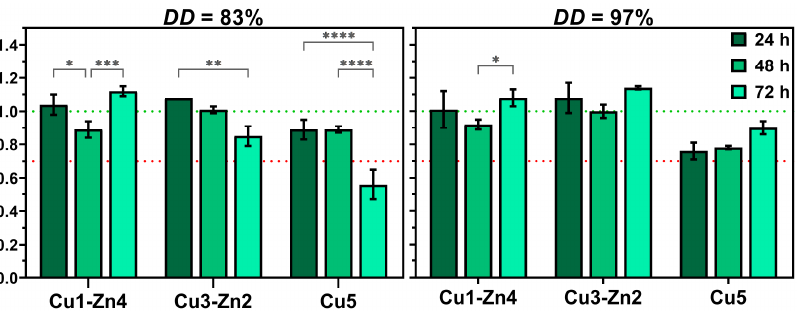
Figure 8. Cell viability of HEK293 cells cultured with material’s supernatant for 24, 48 and 72 h at 37 °C. Signi fi cant di ff erence between groups: * p < 0.05, ** p < 0.01, *** p < 0.001, **** p < 0.0001.